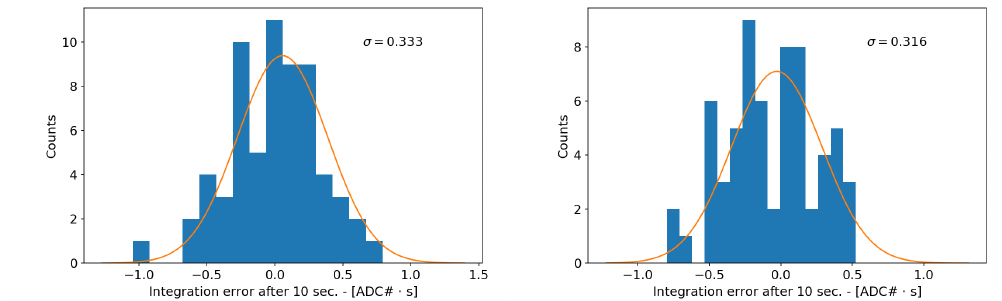
Figure 19. Noise integrated signals from the module with the input amplifier disconnected and fed by the switching DC/DC converter.